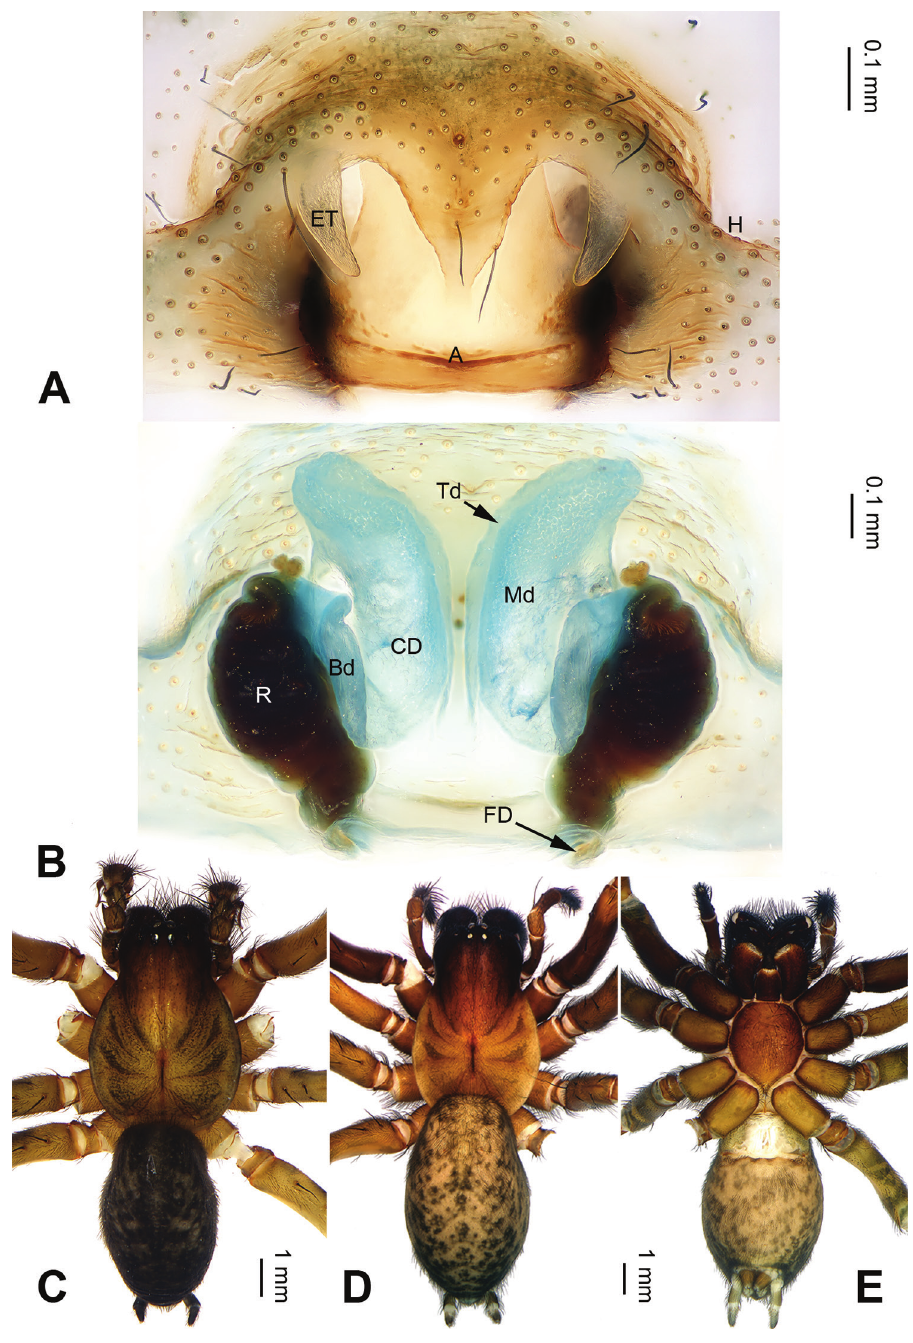
Figure 6. Pireneitega lushuiensis sp. n., female paratype and male holotype. A Epigyne, ventral view B Vulva, dorsal view C Male habitus, dorsal view D Female habitus, dorsal view E Female habitus, ventral view. Scale bars: equal for D, E